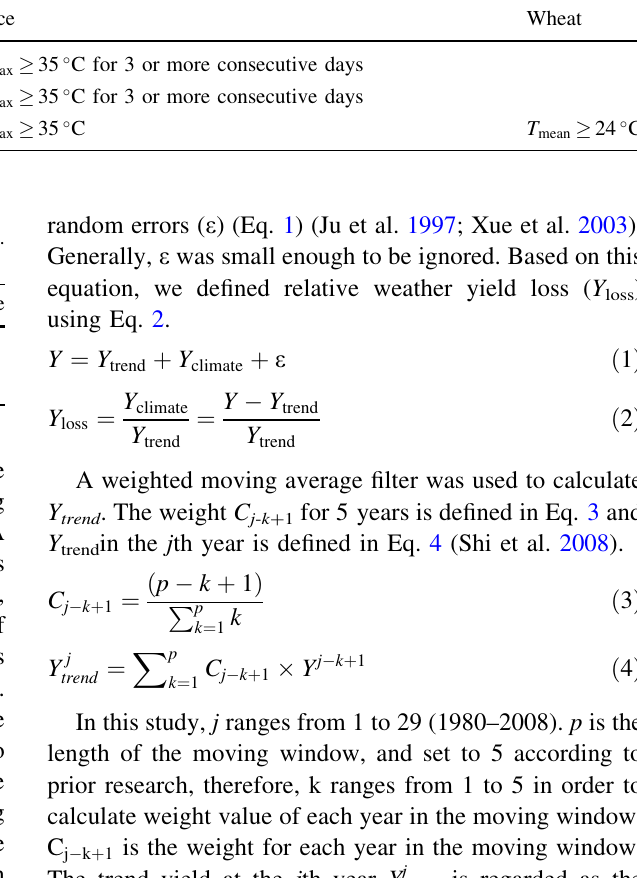
Table 5 High temperature threshold for key growth stages of maize, rice, and wheat. Source General Administration of Quality Supervision, Inspection and Quarantine of the People’s Republic of China and Standardization Administration of the People’s Republic of China (2008) Crop Maize